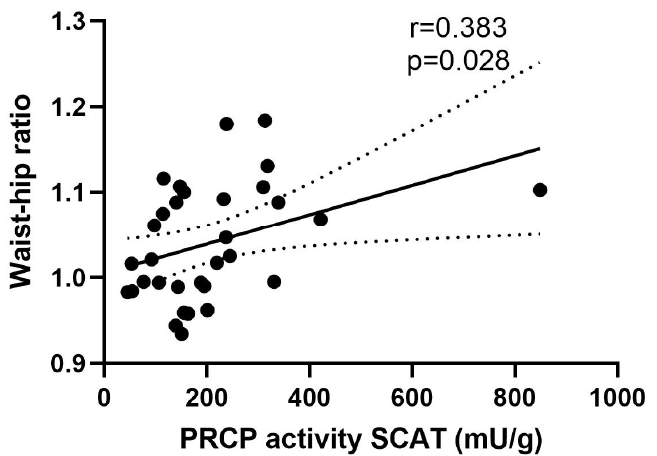
Figure 2. Correlation between PRCP activity in SCAT and waist–hip ratio. Linear regression line is shown with 95% confidence interval (r = 0.383 and p = 0.028). Circles: individual values, solid line: Linear regression line; dotted line: 95% confidence interval for the regression line.